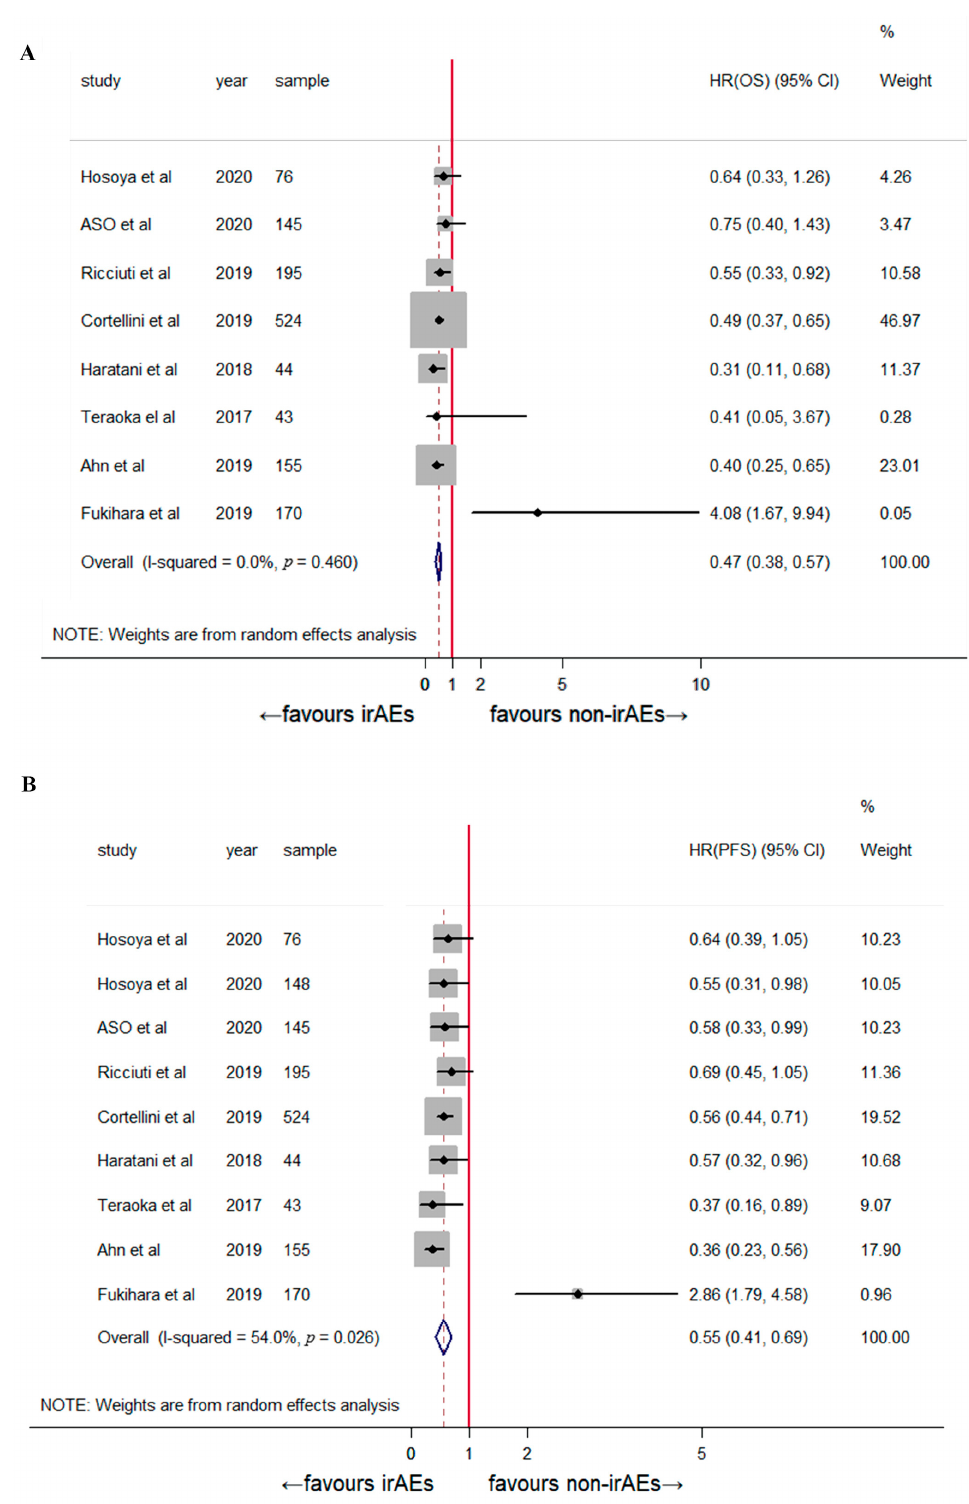
Figure 5. Subgroup analysis of the association between early-onset irAEs and overall survival ( A ) ( A ) [2,8,13–17,21] and progression-free survival ( B ) [2,8,13–17,21] in patients with non-small cell [2,8,13–17,21] and progression-free survival ( B ) [2,8,13–17,21]in patients with non-small cell lung lung cancer.